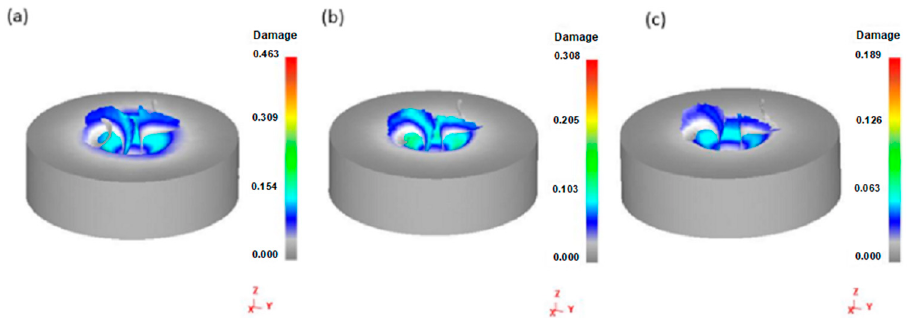
Figure 17. The damage value of materials at a spindle speed of 1000 rpm: ( a ) at a feeding rate of 60 mm/min; ( b ) at a feeding rate of 100 mm/min; and ( c ) at a feeding rate of 140 mm/min.